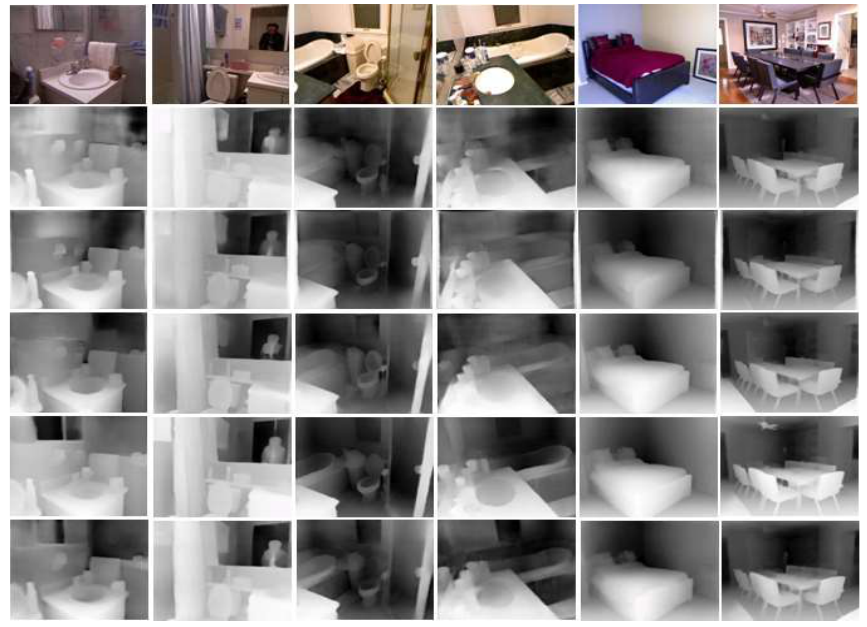
Figure 7. NYU Depth V2 depth map comparison from top to bottom: original RGB, BTS, Lapdepth, Adabins, NeWCRFs, and ours.